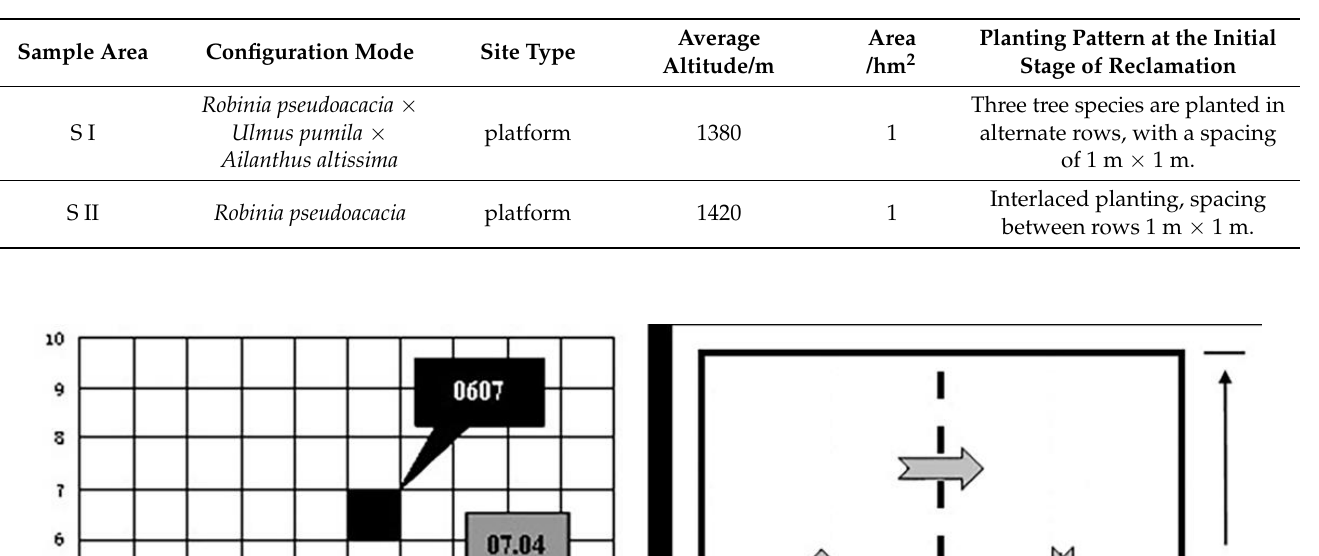
Table 1. Overview of permanently fixed monitoring plots.